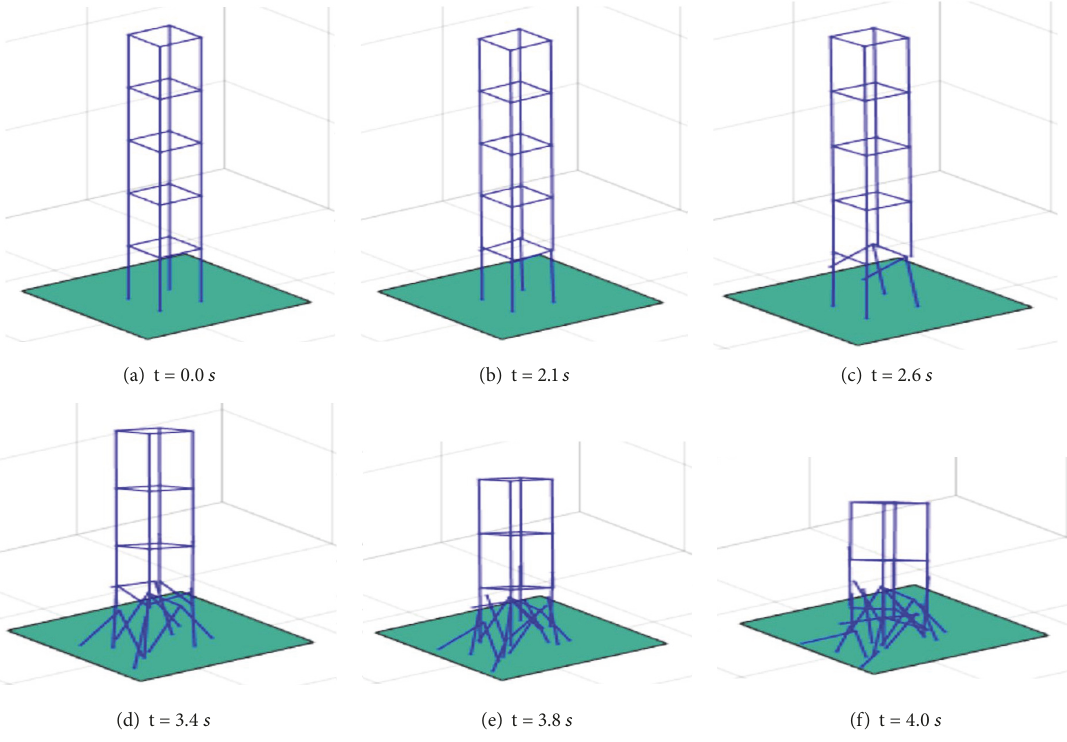
Figure 31: Collapse diagram of steel frame at various